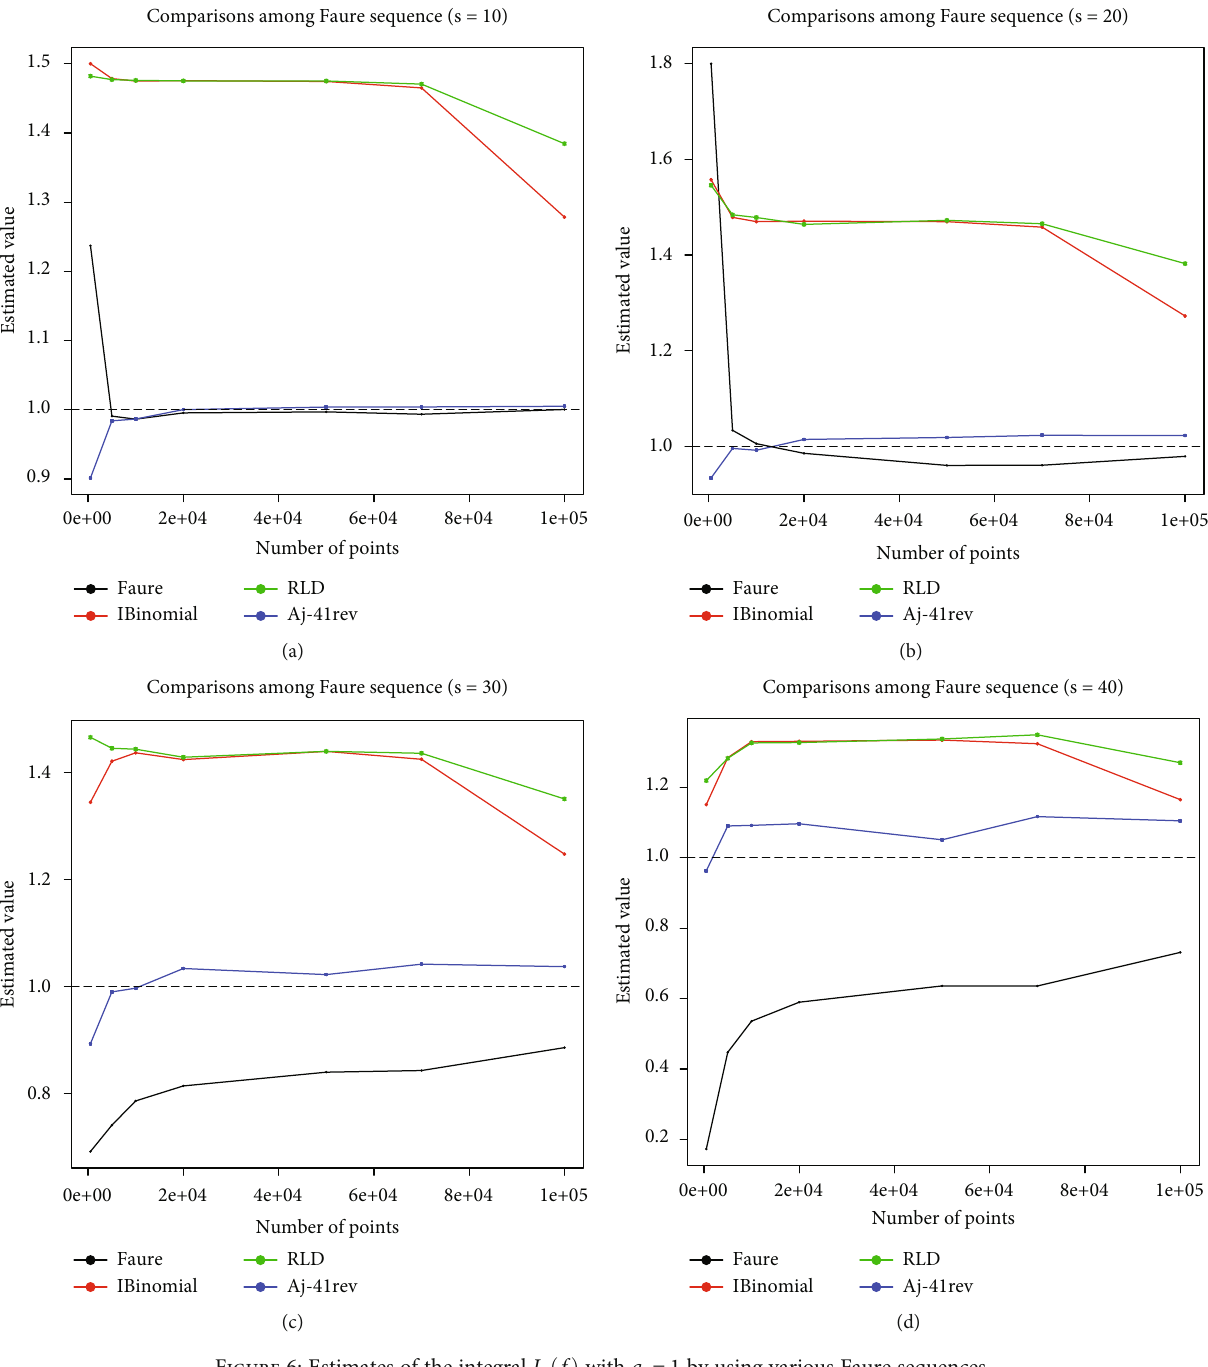
ð f Þ with a = 1 by using various Faure 2 i